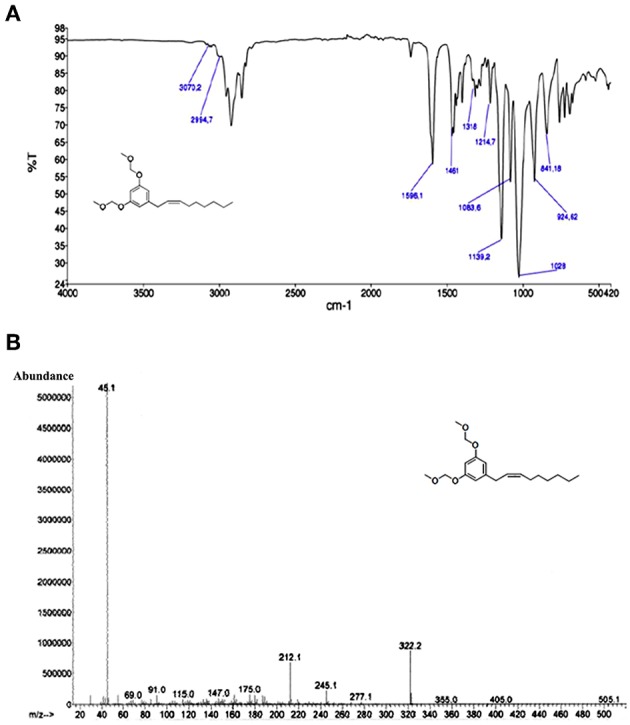
(A) FTIR and (B) EI-MS spectra of MOMO.